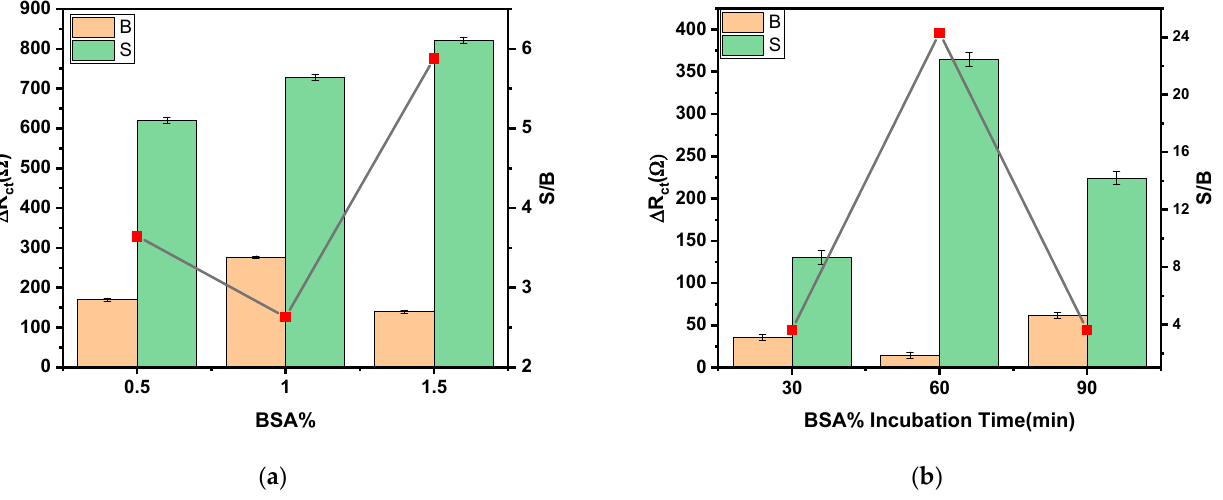
Figure 5. Effect of BSA concentration ( a ) and incubation time with BSA ( b ) on the R ct responses measured with the Anti-GFAP/L-cys/AuNPs/SPCE for 0 (B) and 100 (S) pg mL − 1 GFAP standard solutions.